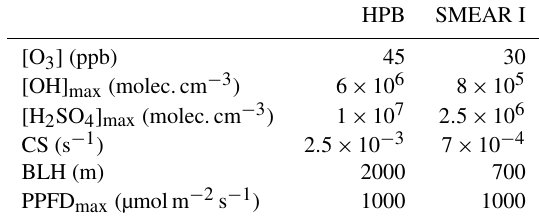
Table 2. Model inputs. Representative summertime conditions in rural central Europe (here indicated by HPB, i.e. the Hohenpeißen- berg Meteorological Observatory) and Lapland (here indicated by the SMEAR I station) are used as default model input. The con- ditions are chosen such that they are realistic and representative, but they do not inhibit the formation of new particles. The concen- trations of OH and sulfuric acid are provided as daily maxima in the table, but their concentrations decrease as a function of the de- crease in solar light in the simulations. The concentration of ozone and the condensation sink (CS) are both kept constant throughout the simulations. BLH is the planetary boundary layer height. The photosynthetic photon flux density (PPFD) is provided as the daily maximum in the table, but the daily pattern of PPFD follows the solar zenith angle in the model.